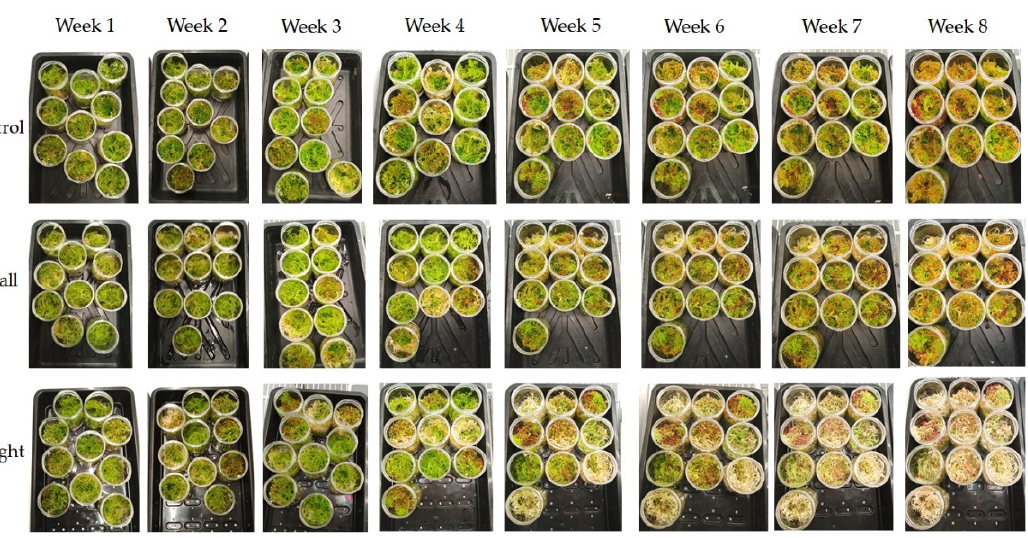
Figure 9. Visual change over time for each group. Note the later onset of visual change within the drought group compared to spectral changes in Figure 8.